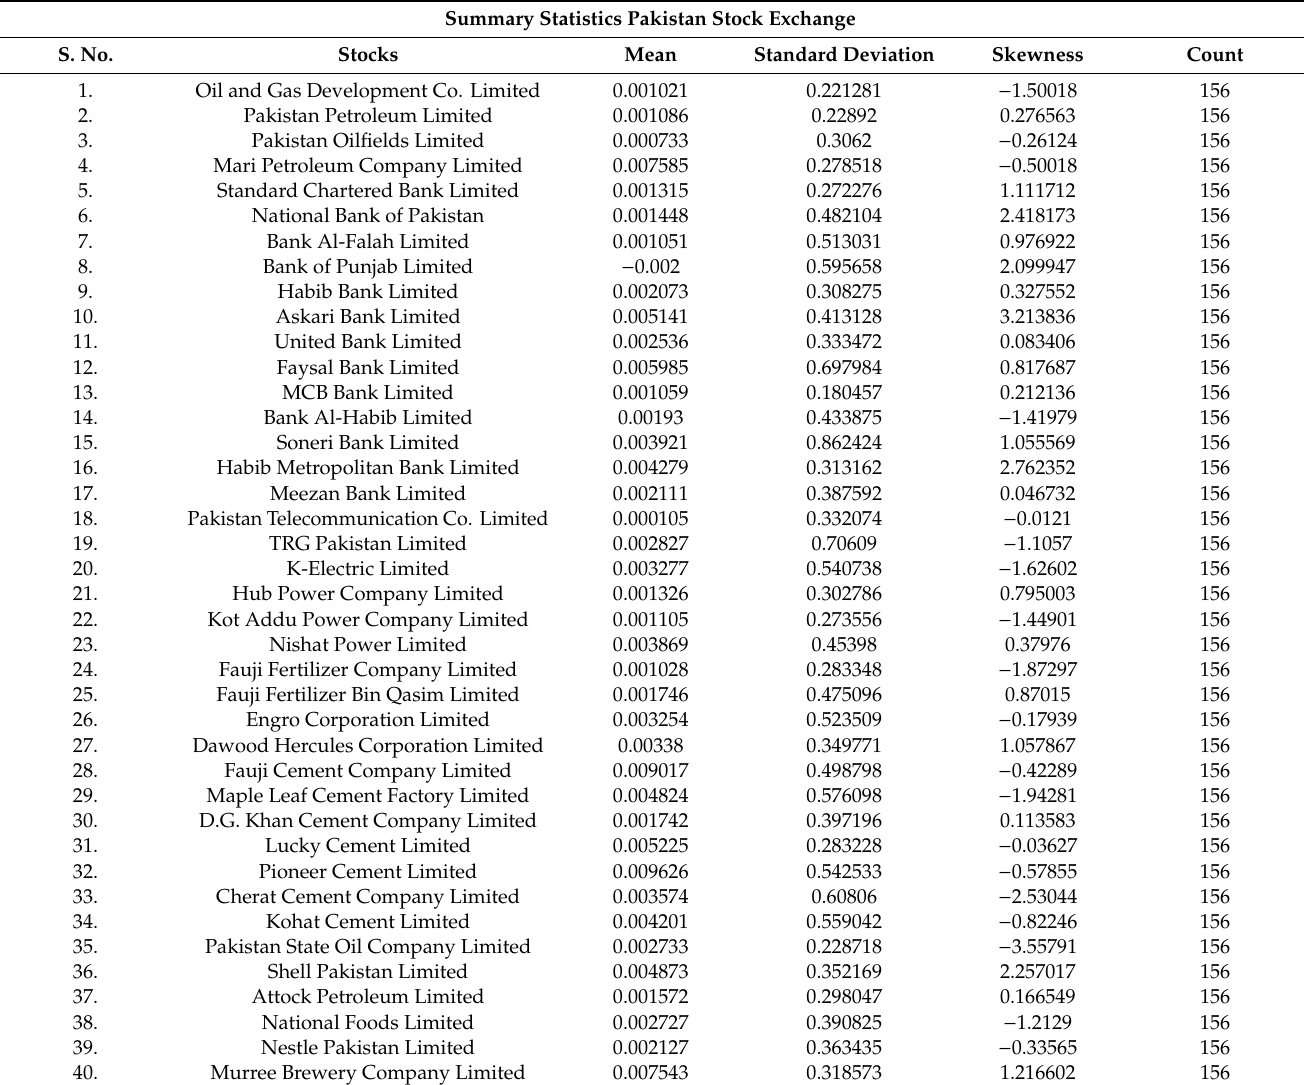
Table A2. Summary Statistics of Pakistan Stock